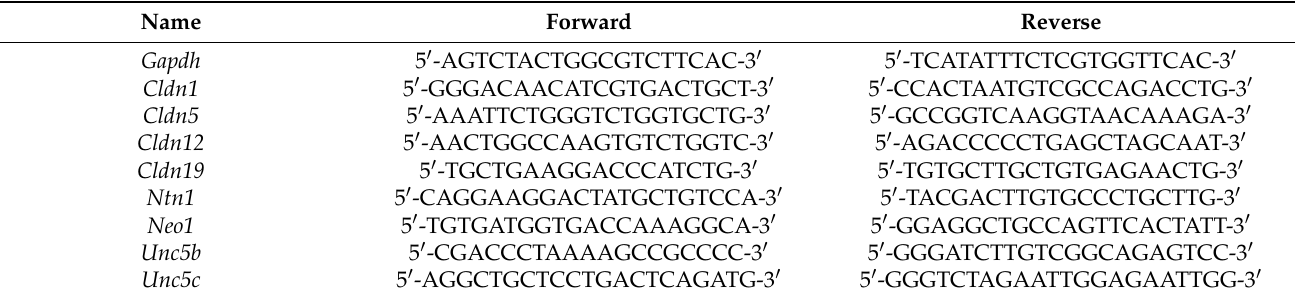
Table 1. The sequence of primers for